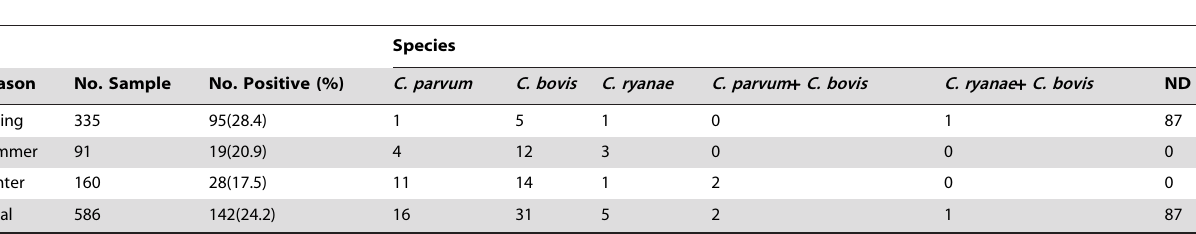
Table 2. Prevalence and molecular characterization of Cryptosporidium spp. in different seasons.